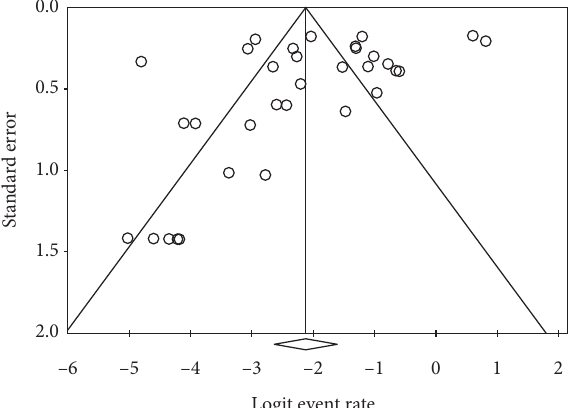
Figure 5: Funnel plot of studies regarding the positive rate of ocular surface RT-PCR for